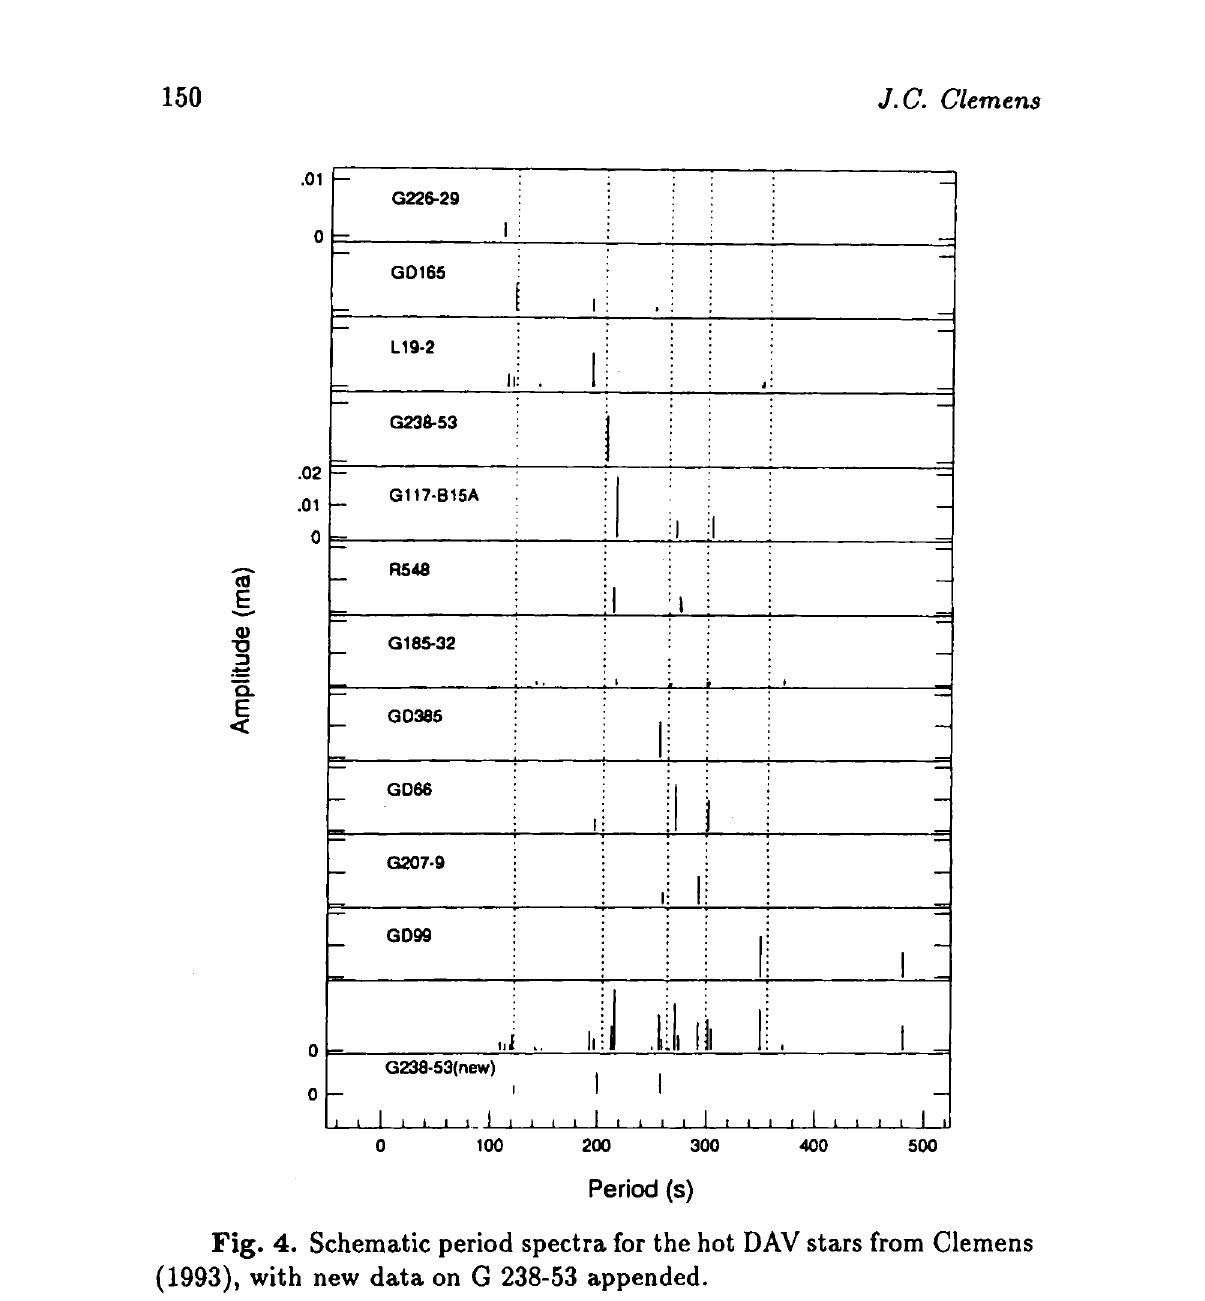
Fig. 4. Schematic period spectra for the hot DAV stars from Clemens (1993), with new data on G 238-53